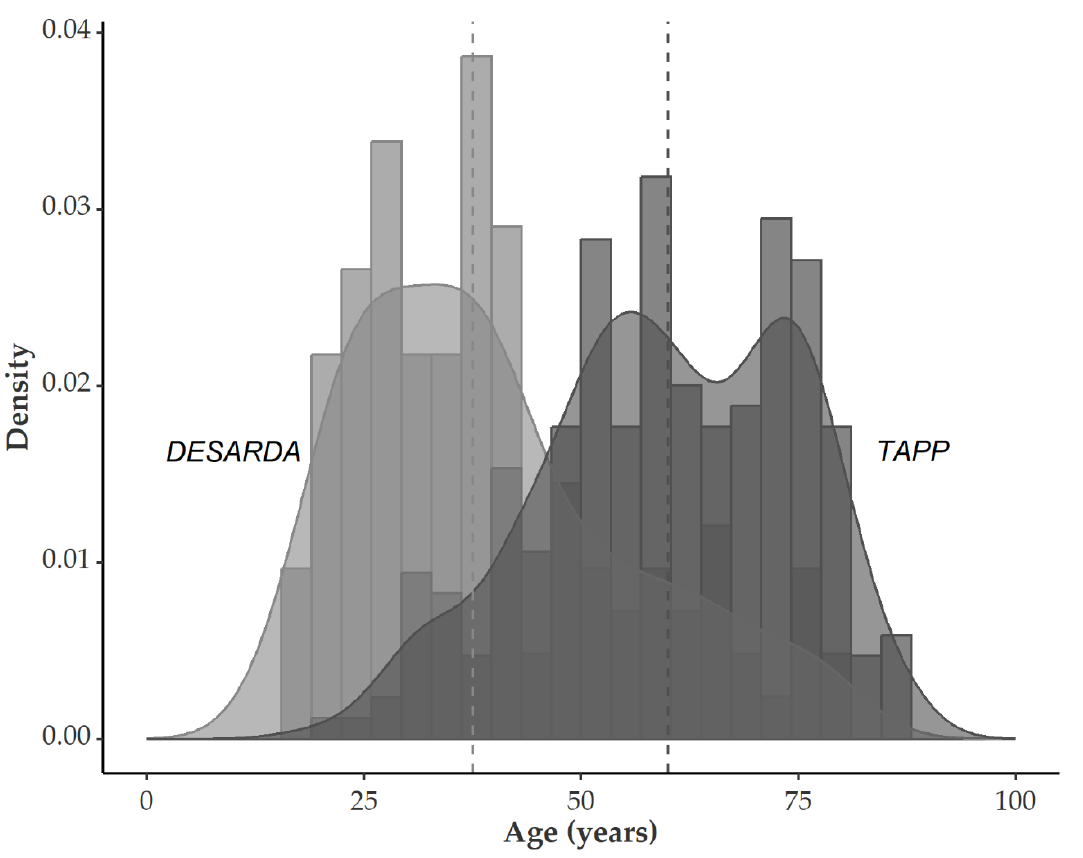
Figure 1. Distribution of age in patients undergoing inguinal hernia repair in our hospital, comparing transabdominal preperitoneal patch plasty (TAPP) to Desarda. The TAPP cohort reflects the age distribution of the patients in our tertiary hospital. Table 1. Baseline characteristics of unmatched patient cohorts by operative method. Data are given as n (%) or median (IQR). Chi-square test or Mood’s median